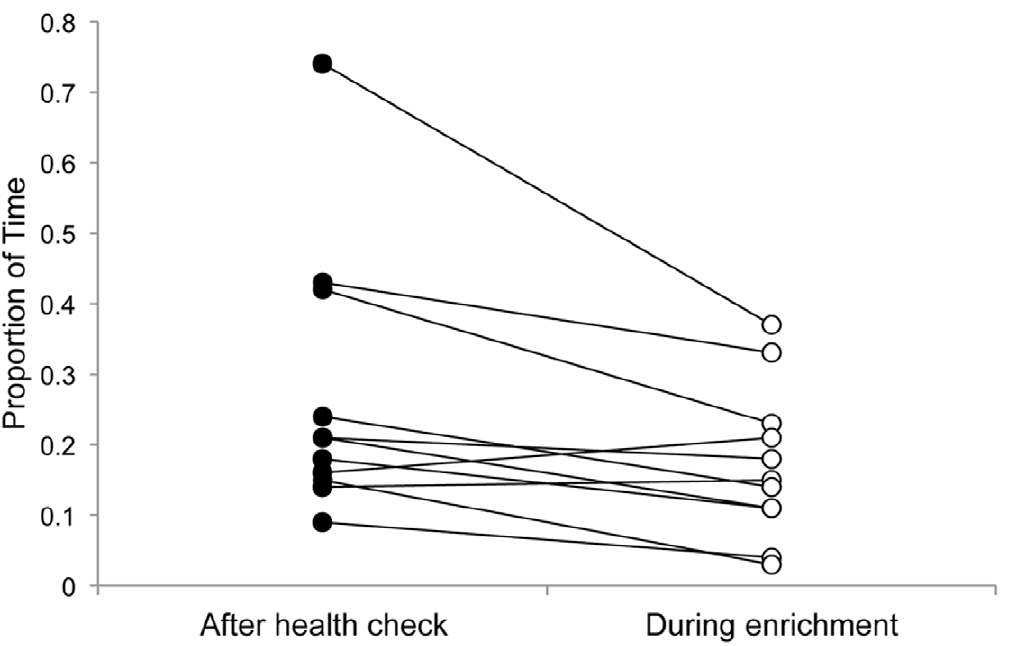
Figure 1. Behavioural indicators of emotion state. Proportion of time monkeys (n=11) engaged in self-directed, stereotypical and self-injurious behaviours after the health check and during the period of enrichment. Lines join the two data points for each animal.